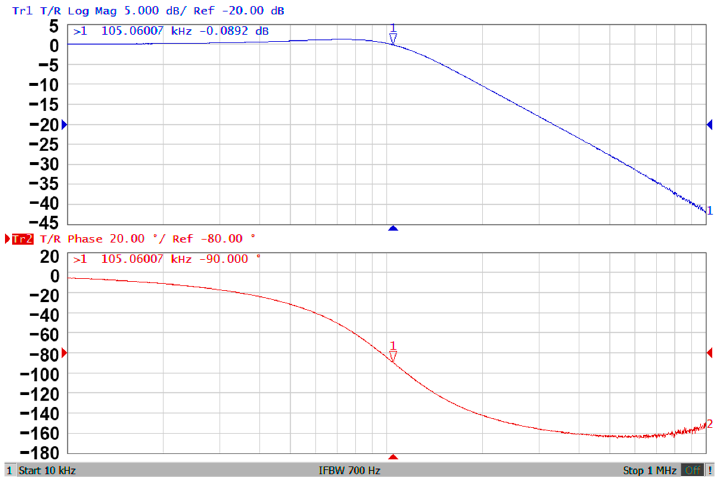
Figure 10. The experimental results of gain and phase responses of the LPF in Figure 2.